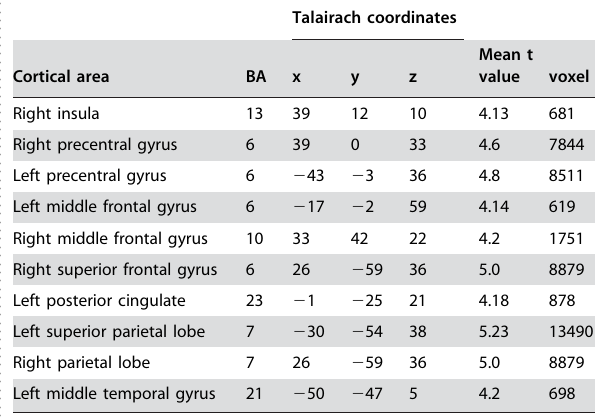
Table 1. Regions commonly activated by single task visual and single task auditory trials, based on a [single task visual –